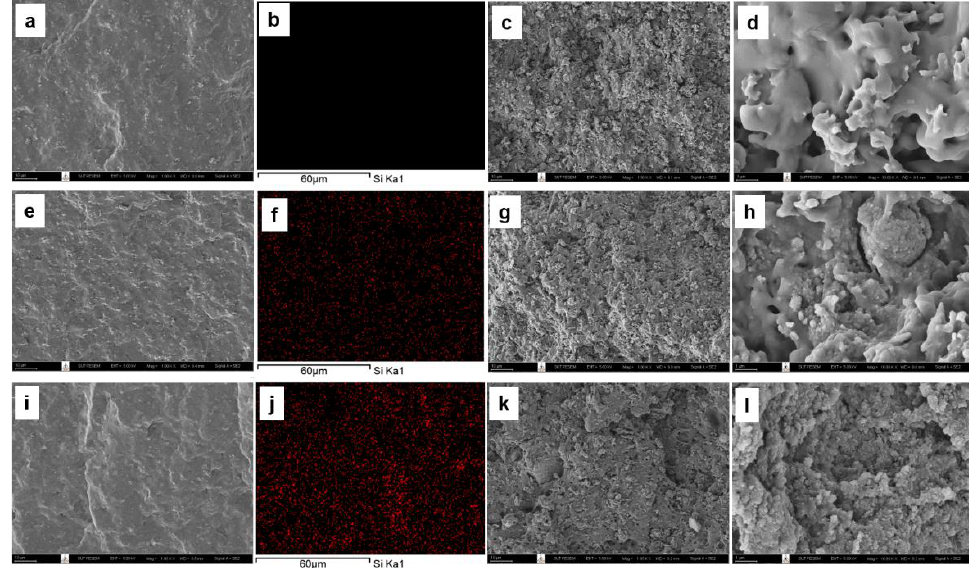
Figure 13. SEM images of freeze fracturing, corresponding EDS (the red spots indicate silica parti- cles), and tensile fracture surface at ×1000 and ×10,000 magnifications of ( a – d ) P30-DPNR; ( e – h ) P30- DPNR-10Si; ( i – l )